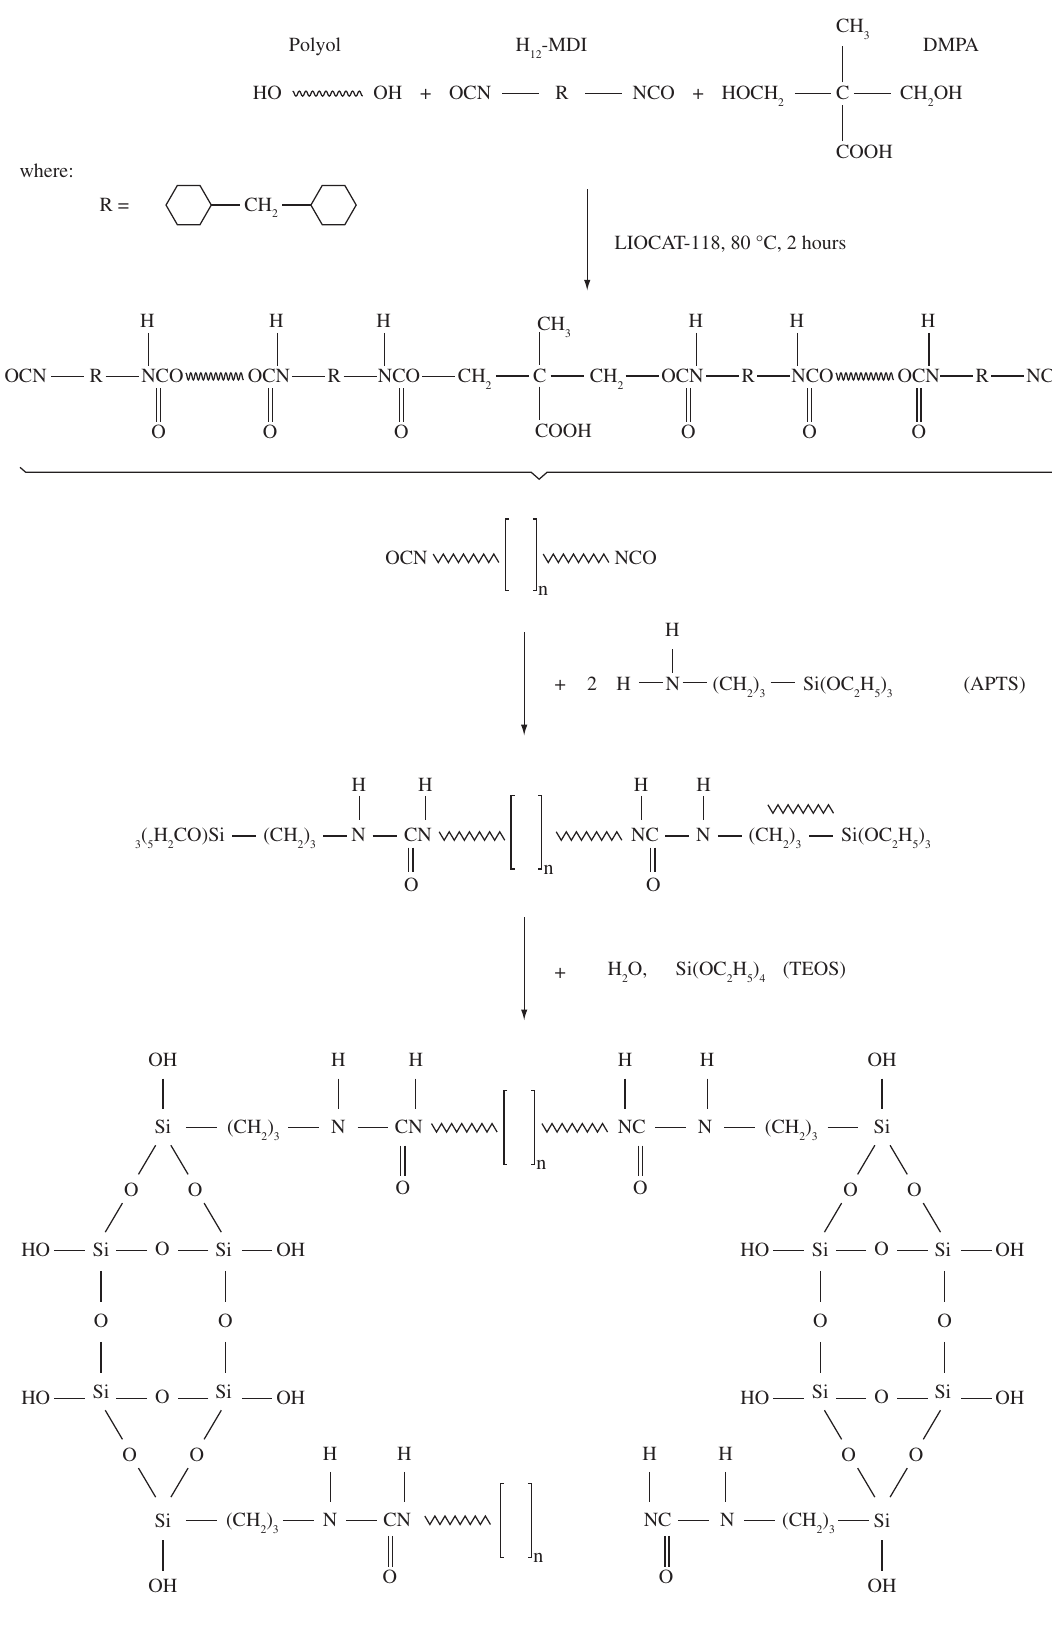
Figure 1. Chemical reactions involved in the production of C2 samples. Chemical reactions involved in C1 samples were the same except for the use of the DMPA